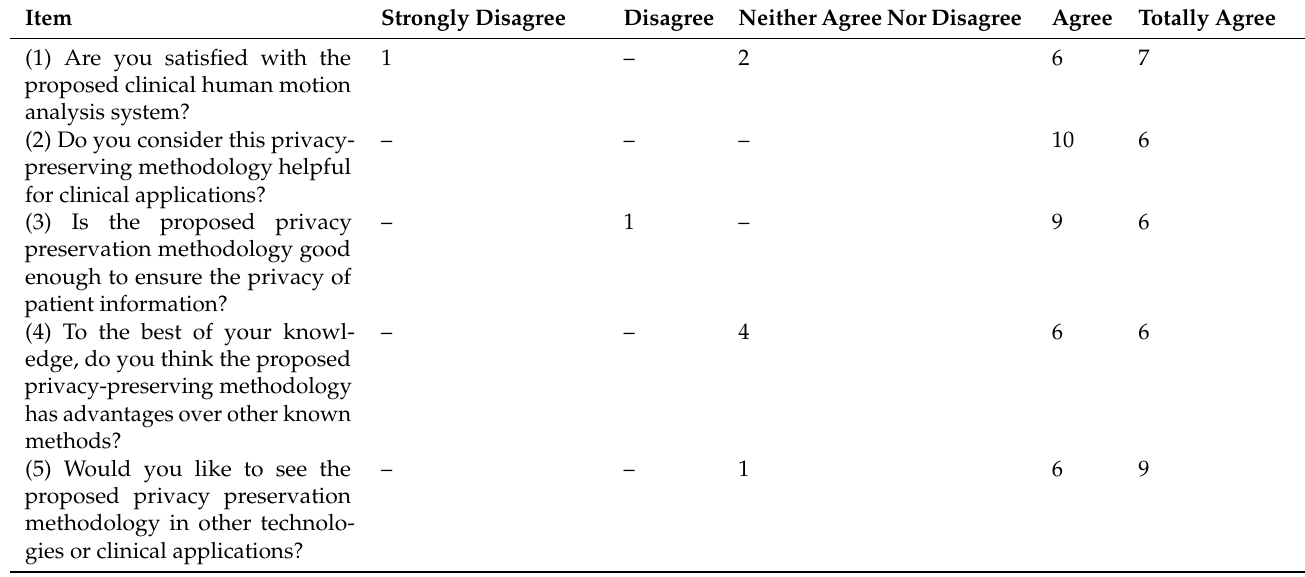
Table 5. Technological appreciation